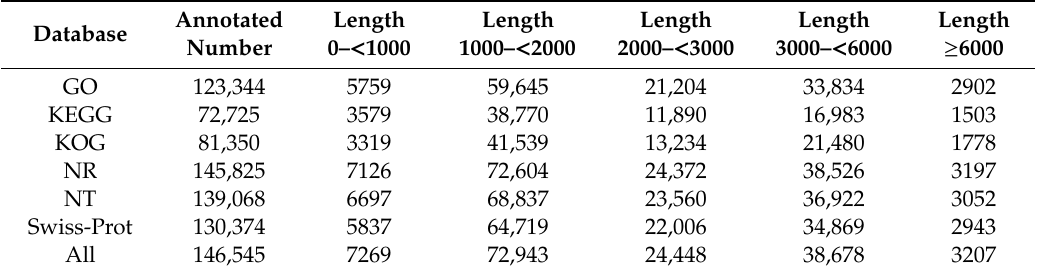
Table 1. Information of function